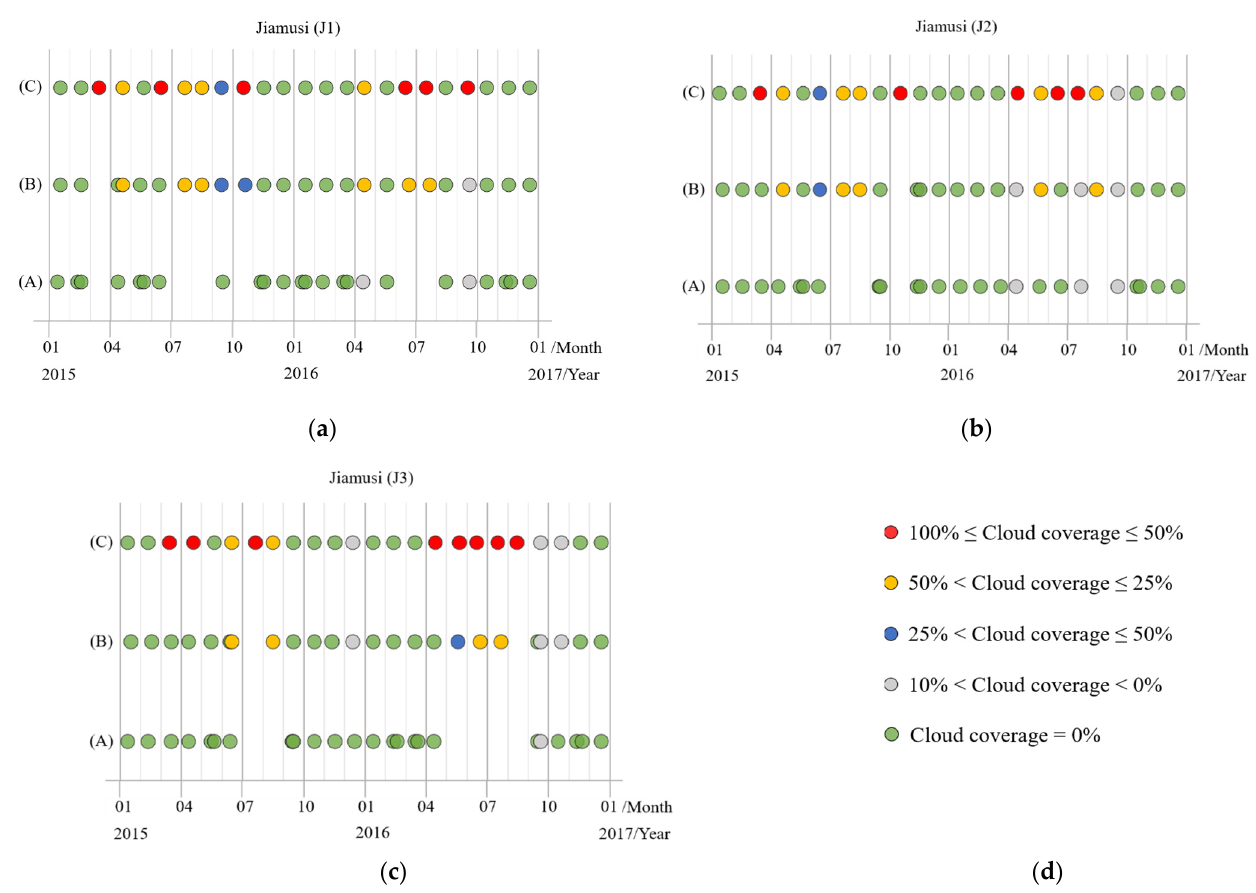
Figure 10. The time series subdata sets with different cloud coverage in the three regions from Jiamusi, in which various colored circles represent images with varying cloud coverage. ( a ) J1 ; ( b ) J2 ; ( c ) J3 ; ( d ) the legend.